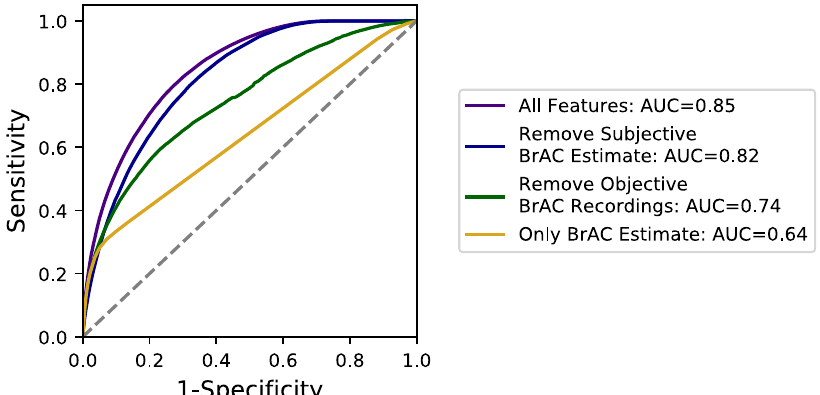
Fig. 2 Final model performance evaluation. To quantify the value of various data sources derived from the smart-breathalyzer device and app, we contrasted the full model with all 46 features to other nested GBCT models, in which we removed different feature(s) (also see Table 1). To benchmark the success of these models, we quanti fi ed a base model, which used the user ’ s subjective BrAC estimate as the sole predictor of the subsequently measured objective smart-breathalyzer BrAC levels. All model parameters were derived from the training set, and evaluated in a separate test set (20%) of randomly selected users not seen by the training set. The full model with all features (purple line) performed substantially better (21% higher; AUC = 0.85 vs 0.64) than the base model with only the user ’ s self-reported BrAC Estimate only (gold line). Removal of the BrAC estimate from the full feature set reduced the AUC by only 3% (blue line), whereas removal of all features derived from prior objective BrAC recordings reduced the AUC by 11% (green line), thereby demonstrating the importance of prior smart-